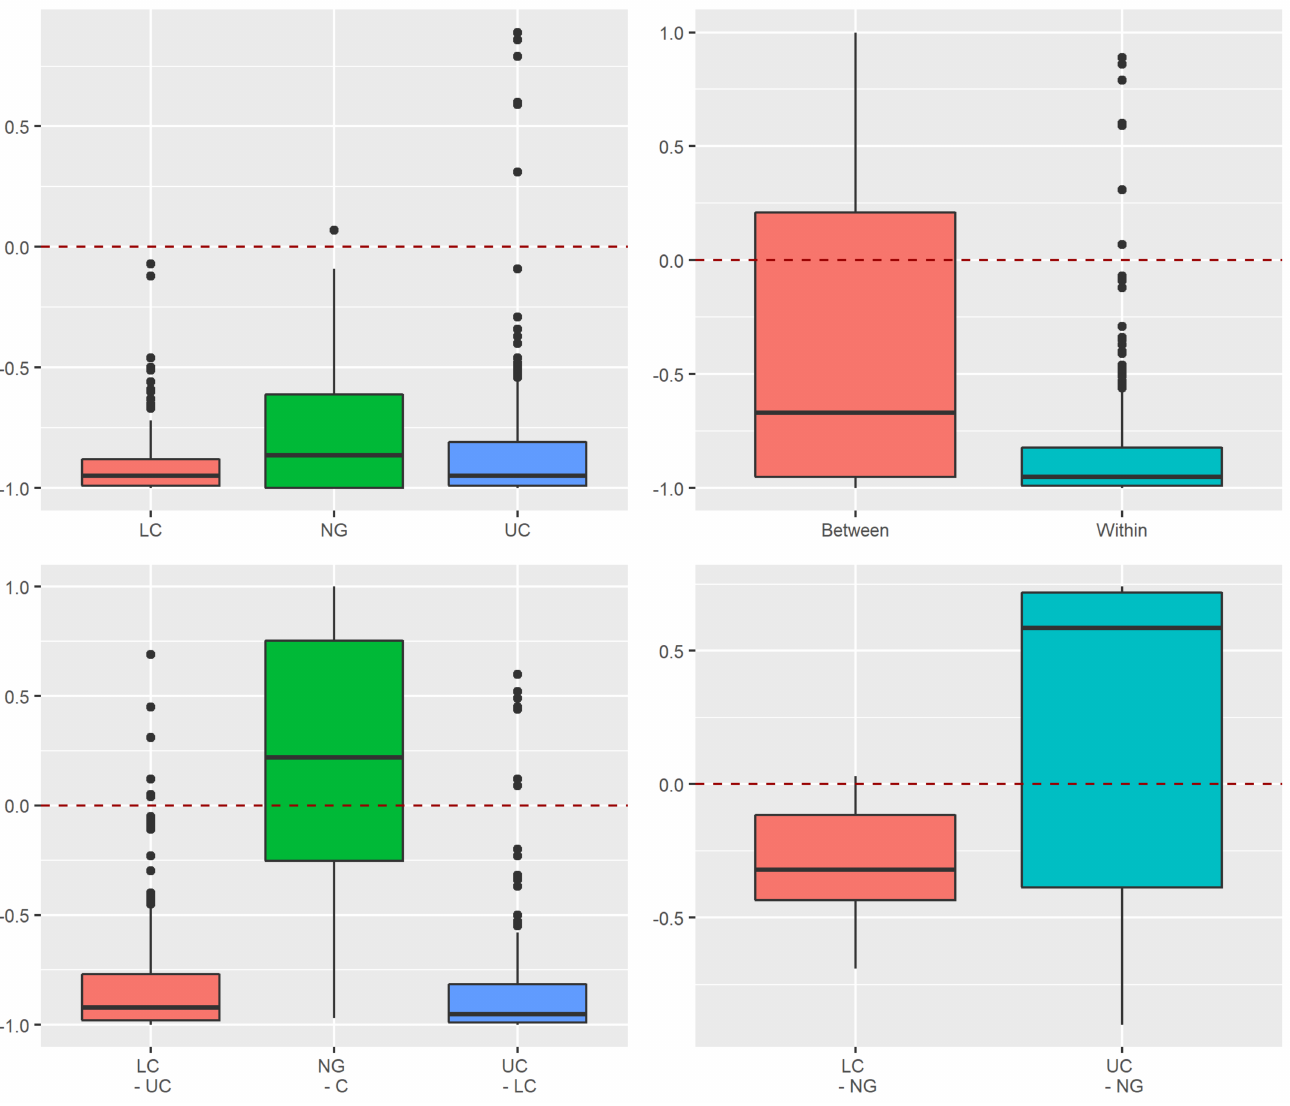
Figure A9. Deviation of the beta diversity from the diversity expected by the null hypothesis per stratum for the common beetle species, rarity classification according to the octaves. NG— near-ground stratum, LC—lower canopy, UC—upper canopy. Comparisons within a stratum are comparisons of two traps of the same stratum. Comparisons between strata are comparisons of two traps from two different